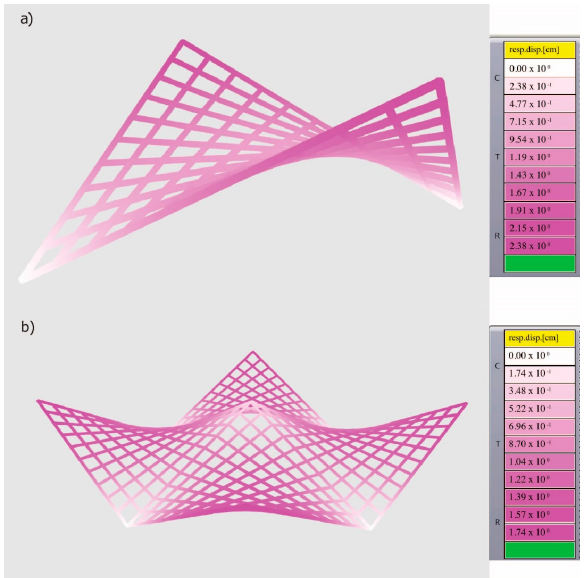
Figure 5. ( a ) Maximum deformations of one module of double curvature shell simulated in Karamba3D; ( b ) Maximum deformations of four modules double curvature shell simulated in Ka- ramba3D.